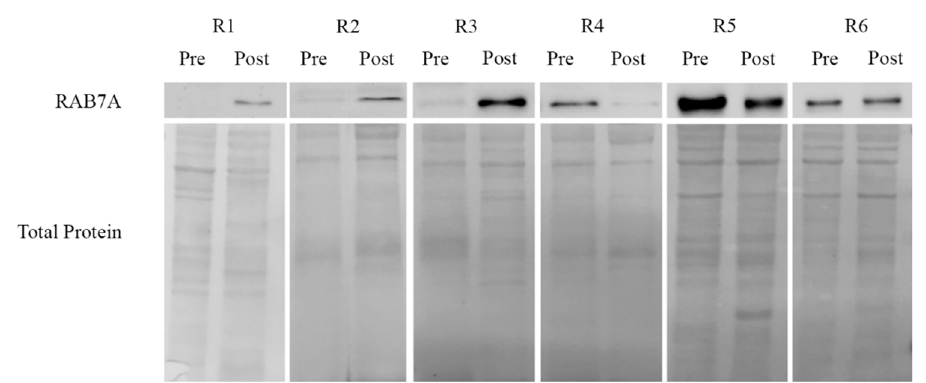
Figure 4. RAB7A expression was evaluated on protein extract from tissue tumor specimens of patients with ovarian cancer disease before (Pre) and after (Post) chemotherapeutic treatment. Levels of RAB7A protein was normalized on total Ponceau S protein staining.